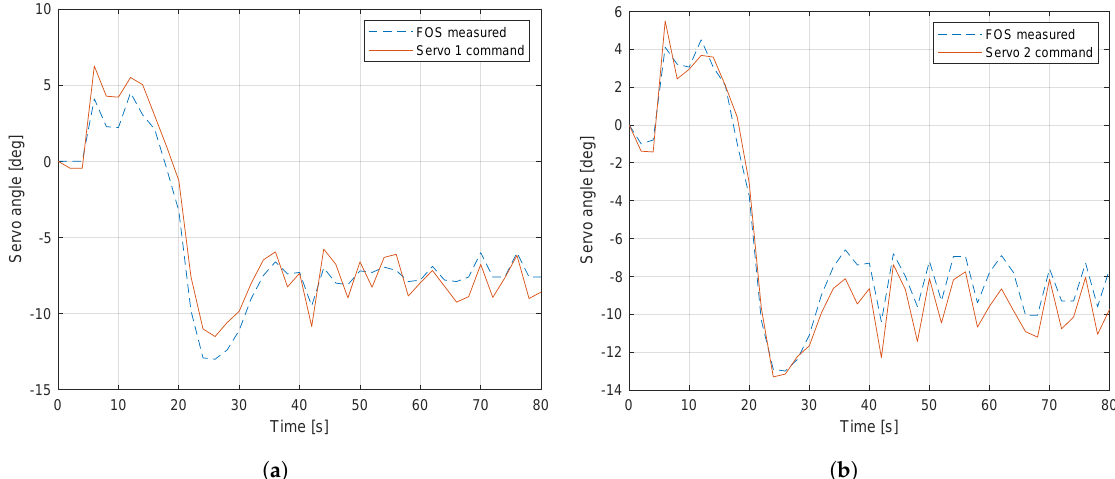
Figure 14. Estimatedposition with respect to module #6 deflections for the F y = 25 and M x = 0 case. The positions of actuators 1 and 2 are separated and shown in ( a , b ), respectively.